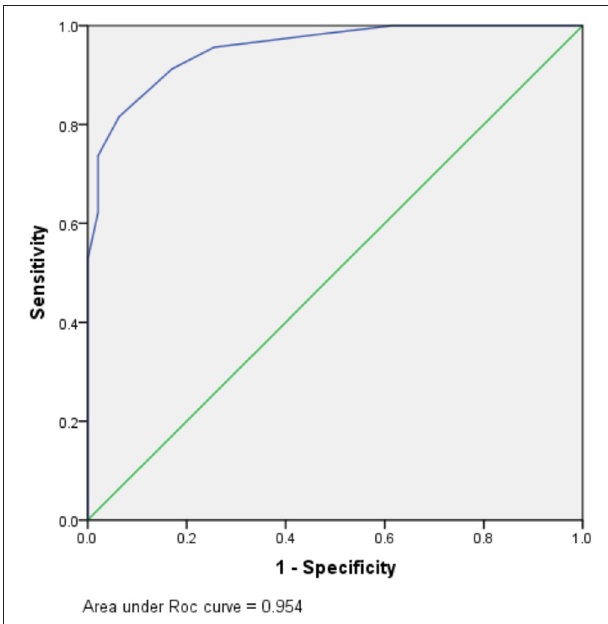
FIGURE 2 | Receiver operating characteristic (ROC) for prognostic indexes from the logistic regression model.